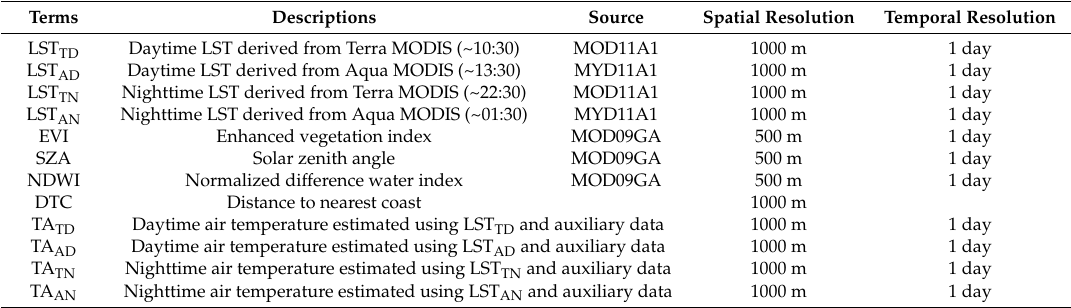
Table 1. Descriptions of variables used in air temperature